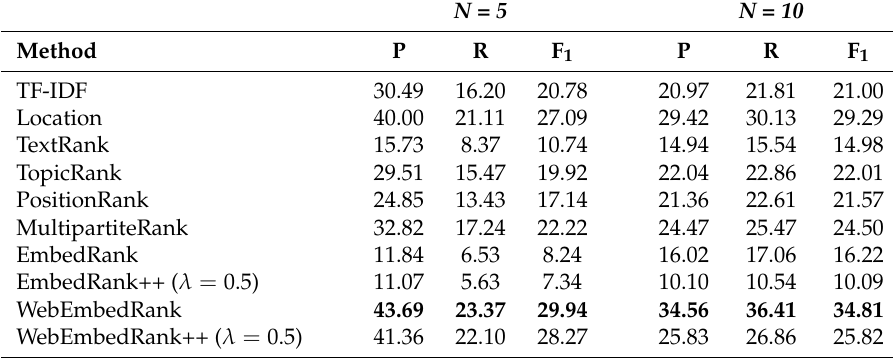
Table 2. Scores of WebEmbedRank compared to various other state-of-the-art keyphrase extraction methods on the newly constructed web page dataset for the top 5 and top 10 extracted phrases. P denotes the precision, R the recall and F 1 the micro-F 1 score. The highest scores are marked in bold. N = 5 N =